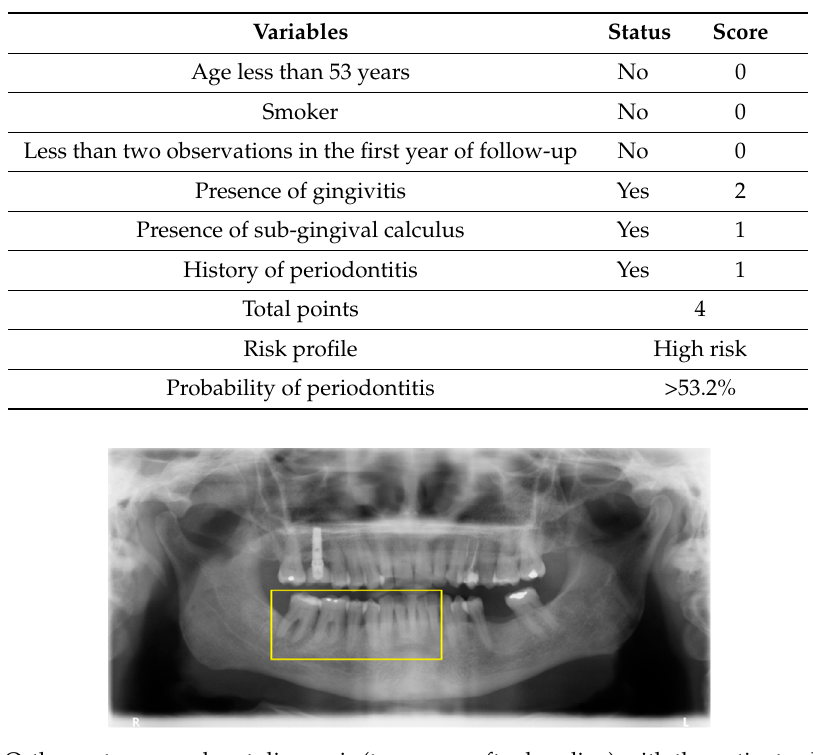
Table 4. Patient profiling using the risk score at the baseline appointment. According to the clinical evaluation, the presence of gingivitis, subgingival calculus and history of periodontitis were noted, scoring an overall 4 points for a high risk of periodontitis.